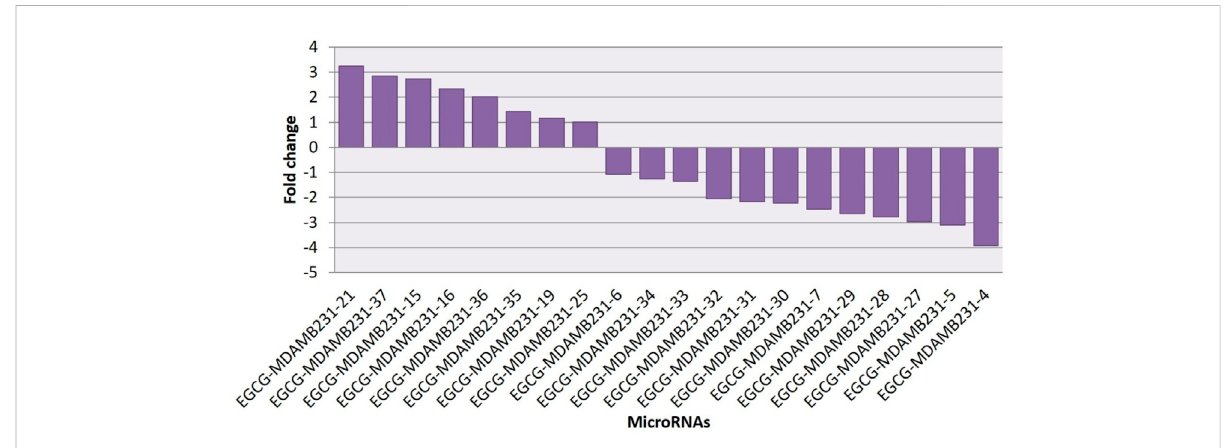
FIGURE 10 All up- and down-regulated novel microRNAs between untreated control vs. 24 h of 83 μ M EGCG treatments.